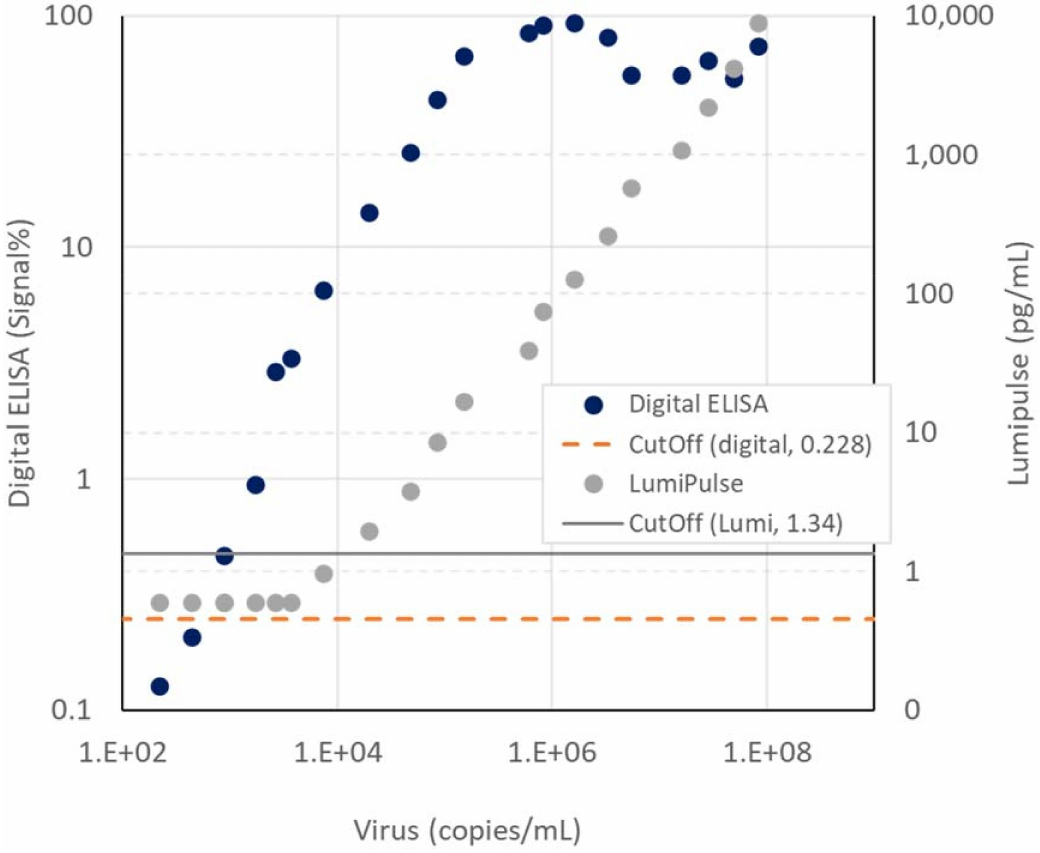
Figure 5. Results of the measurement of 0, 217, 434, 869, 1708, 2634, 3367, 7335, 1.96 × 10 4 , 4.77 × 10 4 , 8.42 × 10 4 , 1.49 × 10 5 , 5.97 × 10 5 , 8.14 × 10 5 , 1.61 × 10 6 , 3.32 × 10 6 , 5.45 × 10 6 , 1.58 × 10 7 , 2.85 × 10 7 , 4.90 × 10 8 , and 8.31 × 10 8 copies/mL diluted samples. Cutoff: 0.228% for d-IA and 1.34 for